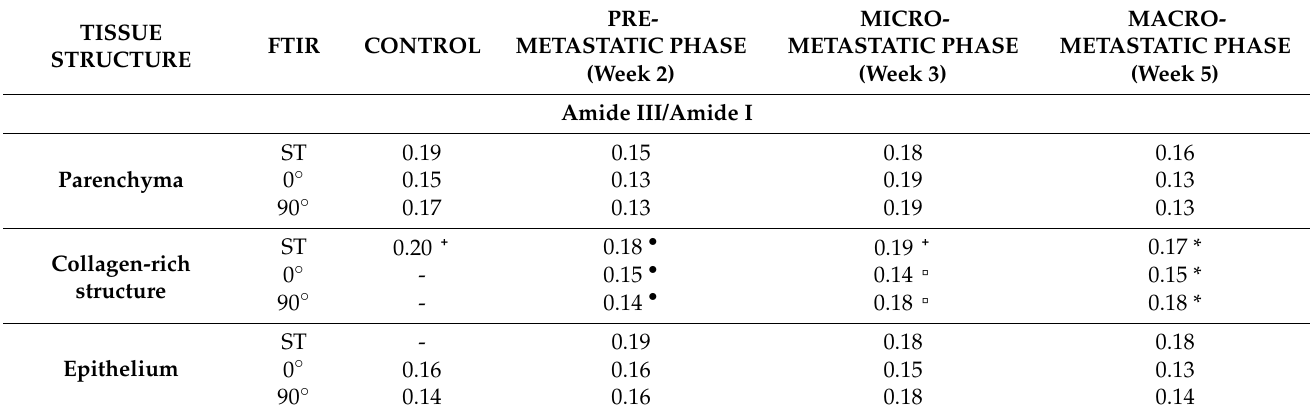
Table 1. Correlation of calculated ratios for each stage of cancer progression, standard and polarized FTIR spectroscopic